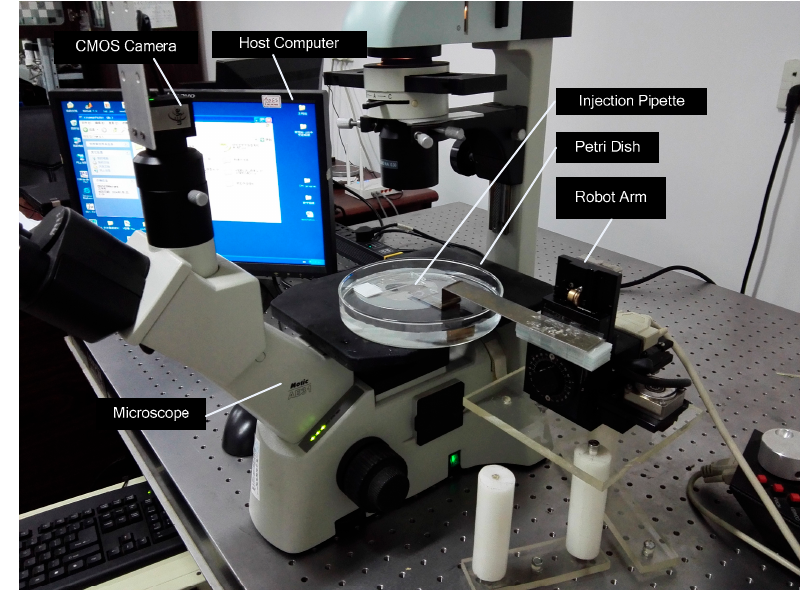
Figure 2. The photograph of the automatic microinjection system.